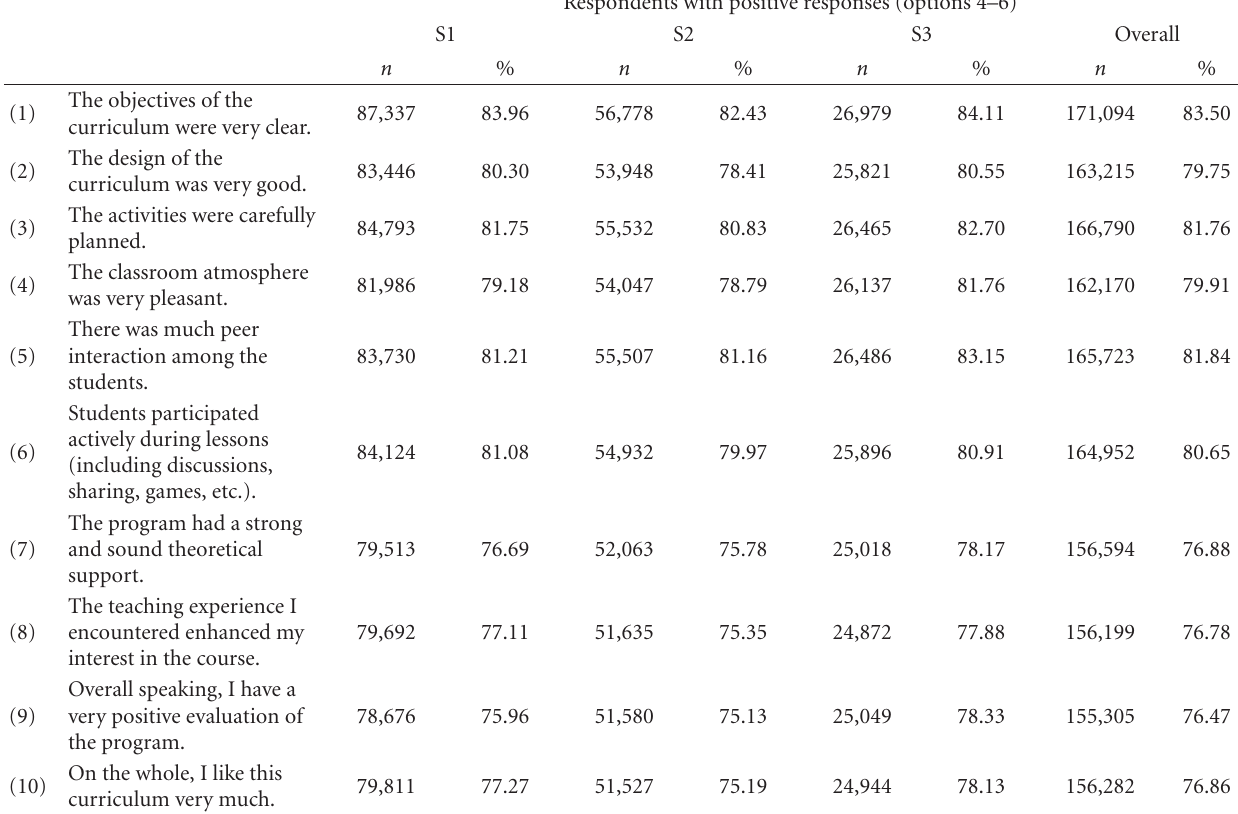
Table 2: Summary of the students’ perception towards the